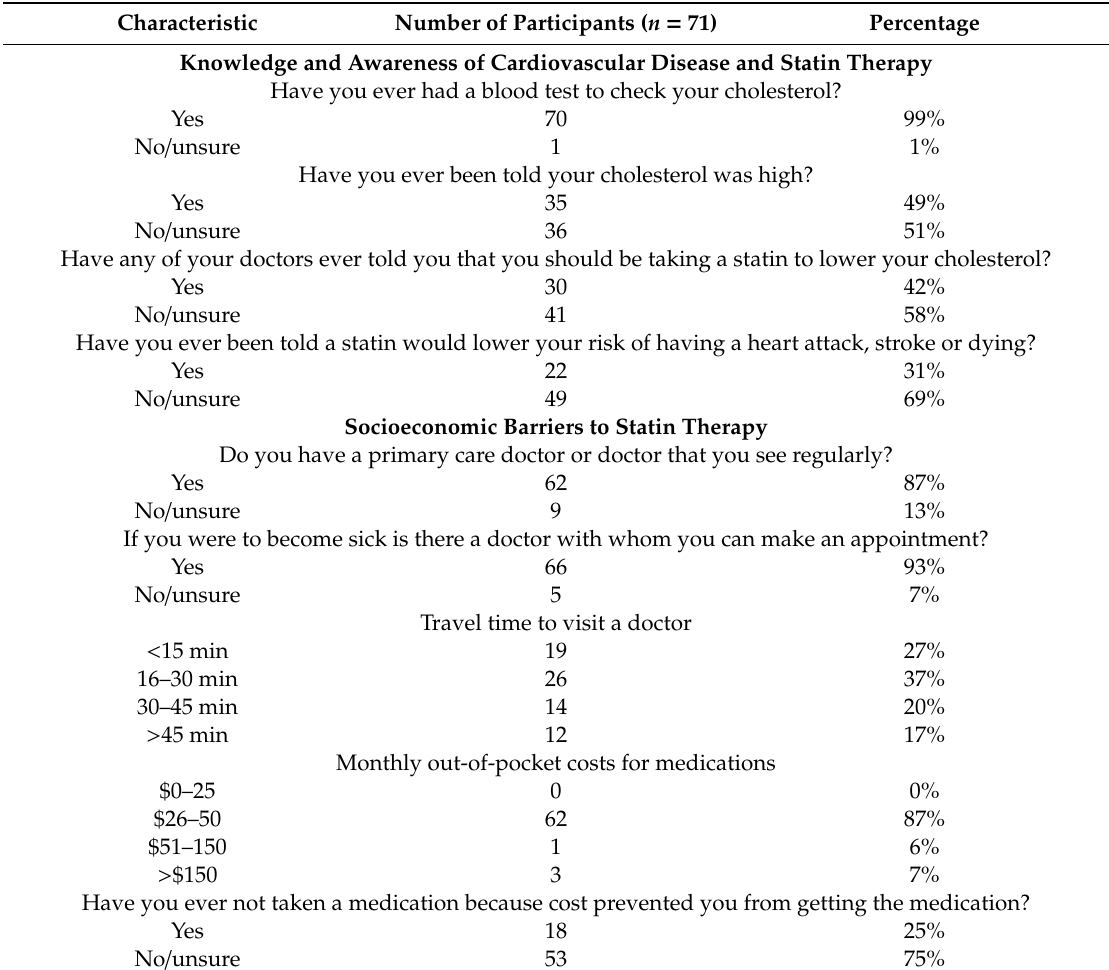
Table 2. Knowledge about Statin therapy and Barriers to